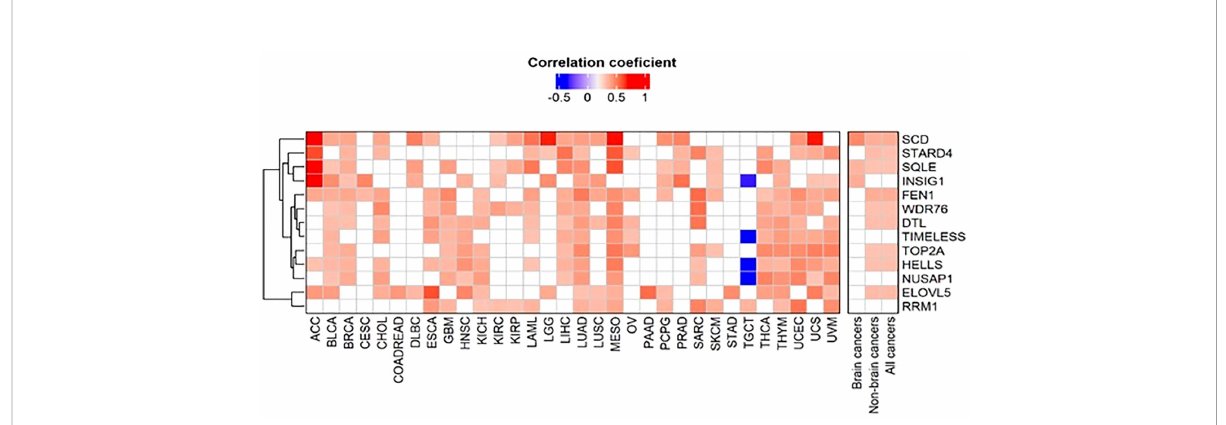
FIGURE 4 Clustered heatmap of genes correlated with FADS1. The correlations between the RNA expression levels of FADS1 and those of other genes were calculated using Spearman ’ s correlation. Of genes that have a Spearman ’ s correlation coef fi cient ≥ 0.3 or ≤ -0.3and a p value<0.05, those that were present at least 50% of all cancer types (i.e., 16 cancer types) were selected for the heatmap analysis. For all cancers, non-brain cancers, and brain cancers median was used to summarize correlation coef fi cient and Fisher ’ s combined probability test was used for p values. The heatmap is depicted using the Spearman ’ s correlation coef fi cients. The empty cell in the heatmap represents that a gene was not correlated with FADS1 in the corresponding cancer type.